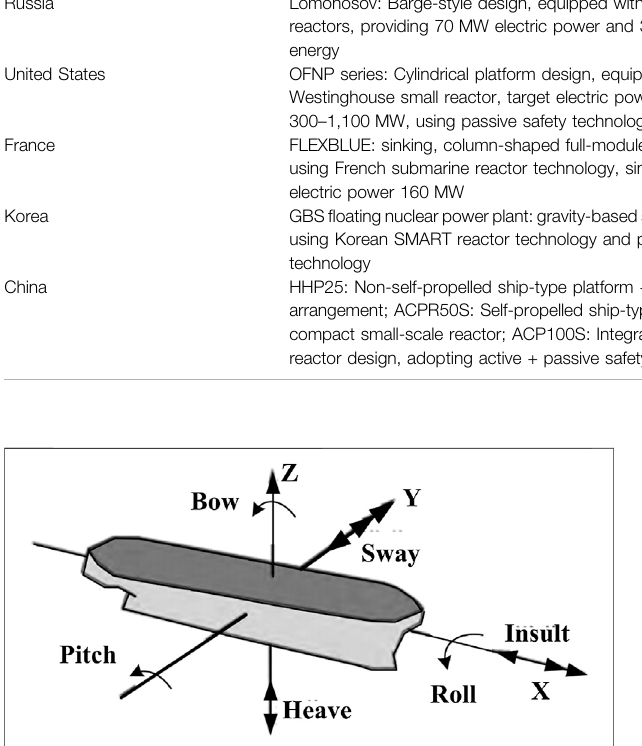
FIGURE 1 | Six degrees-of-freedom ship motions under ocean